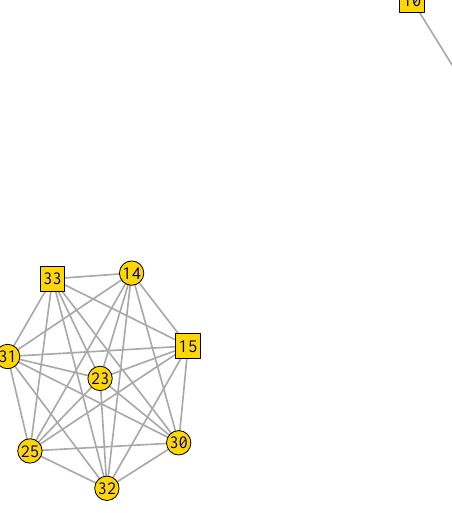
Figure 3. Reproduction ( rep ) GFN. 10 genes and 29 pair connections in two disconnected sub-graphs. TF represented by squares, while other genes are represented by circles (Supplementary SI.5 for gene descriptions).